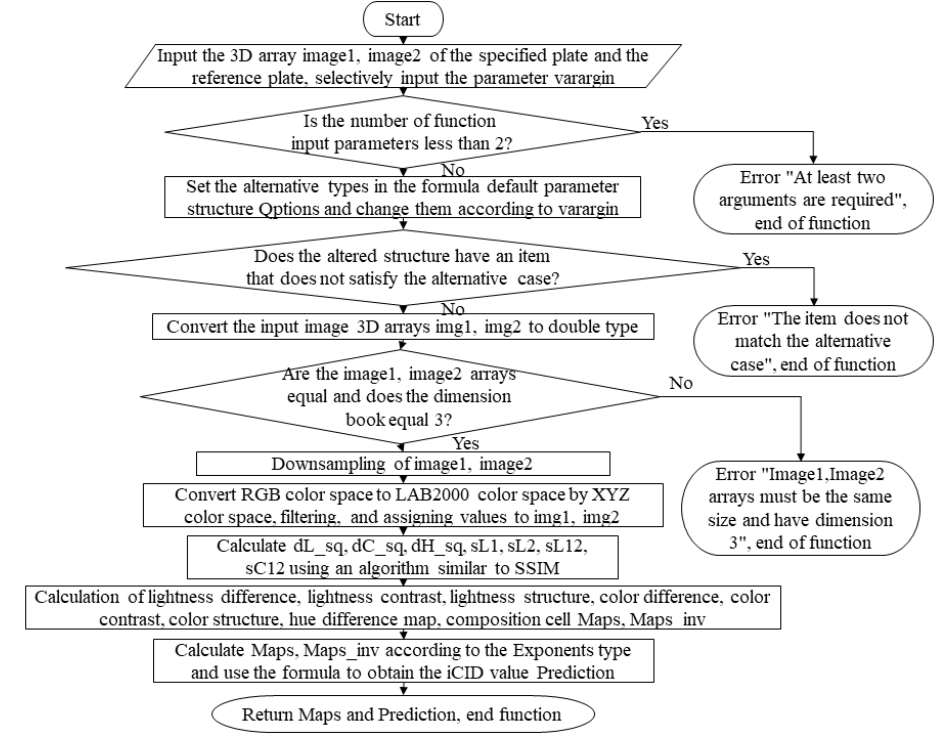
Figure 4. Compilation framework for the iCID algorithm.